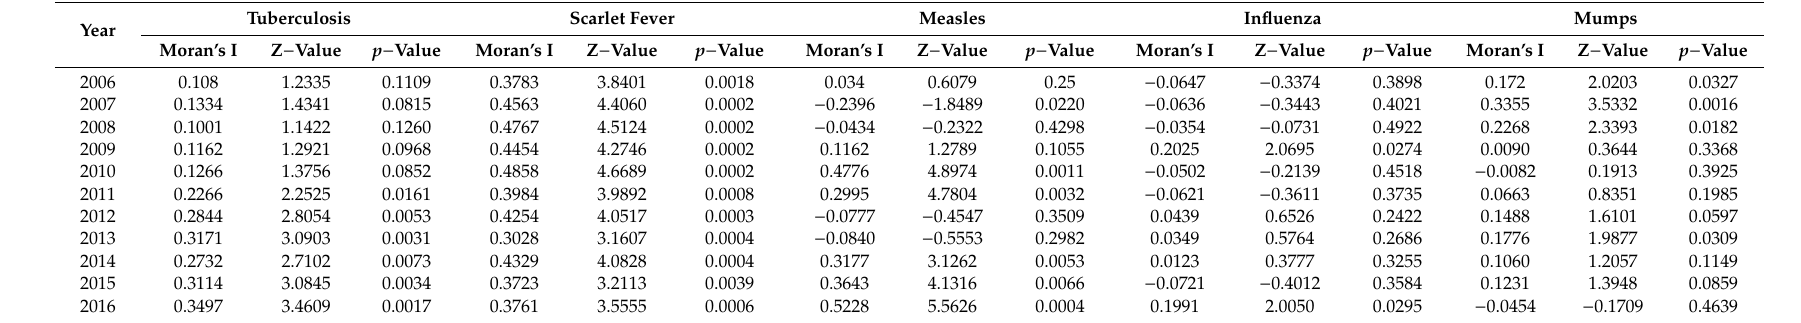
Table 3. Global spatial autocorrelation analysis and test